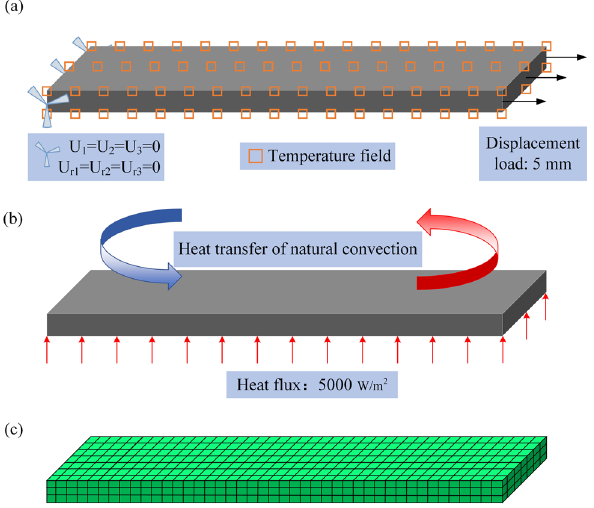
Figure 8: Comparison of experimental and simulation